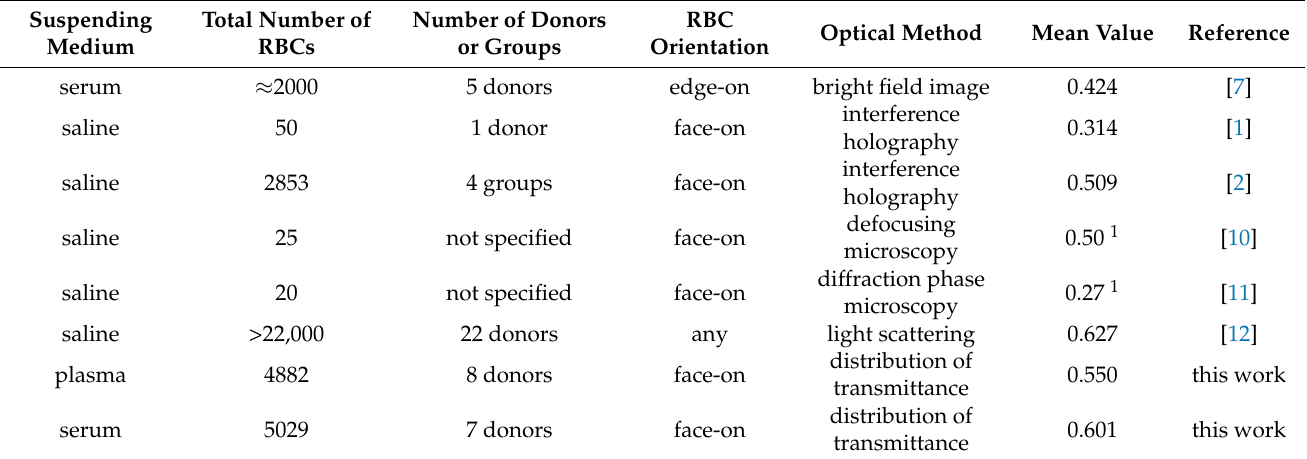
Table 5. Measurements of the